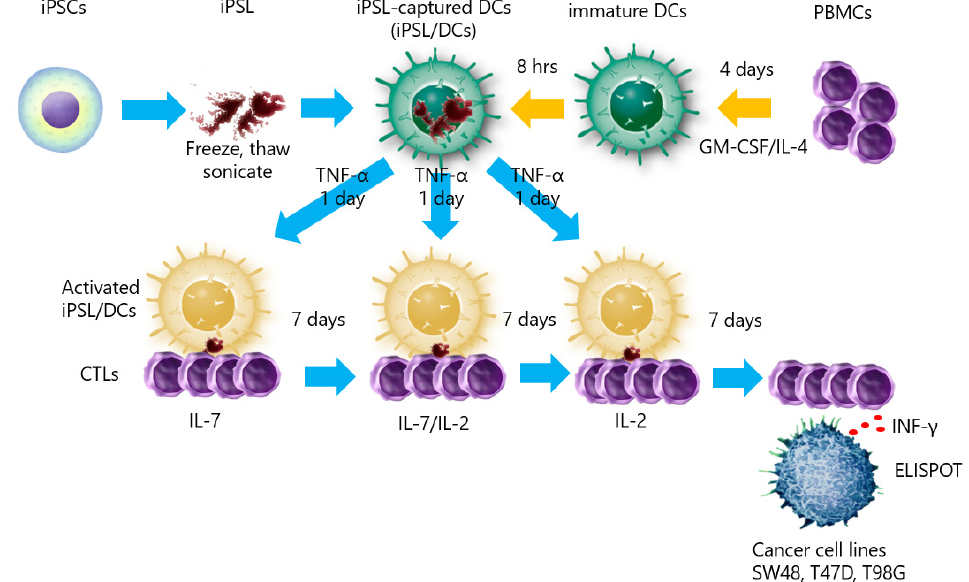
Figure 5. Schematic representation of CTLs induced by iPSL/DCs. iPSL was prepared by freeze– thawing and sonication. DCs were induced by rhGM-CSF and rhIL-4 for 4 days. The immature DCs were loaded with iPSL for 8 h and activated for 24 h with rhTNF- α . The iPSL/DCs were co-cultured with CTLs in the presence of rhIL-7, re-stimulated by iPSL/DCs, rhIL-2, or rhIL-7 weekly, and cultured for 3 weeks.